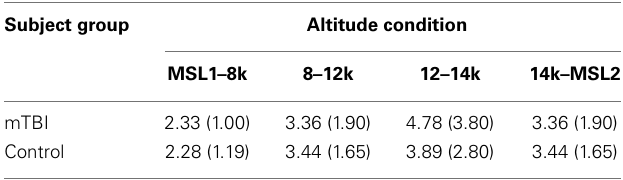
Table 3 | Mean (SD) duration in minutes between experimental conditions.